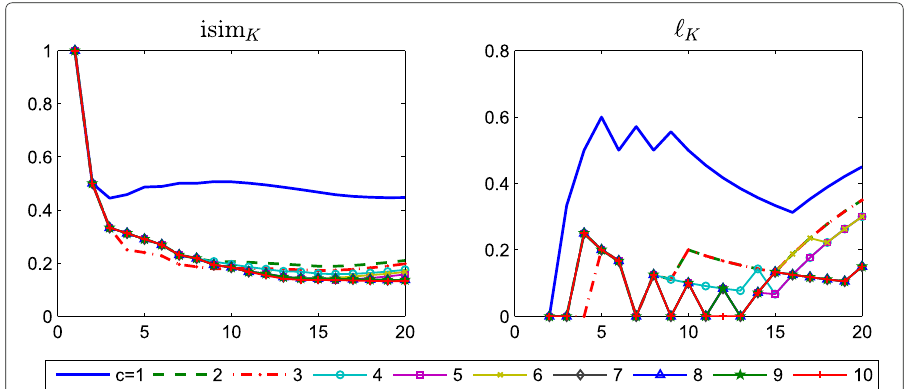
Fig. 9 Vary c . Real: behaviour of isim K and (cid:6) K with respect to K , using α =